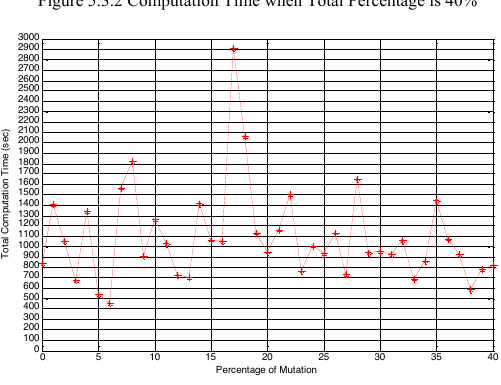
Figure 5.3.3 Computation Time for Population Size, 1,500 Figure 5.3 Total Percentage of Mutation and Crossover is 40% (Mutation over Crossover) Figure 5 Generation Number, Computation Time, and Computation Time when Population Size is 1,500 after reaching the threshold of